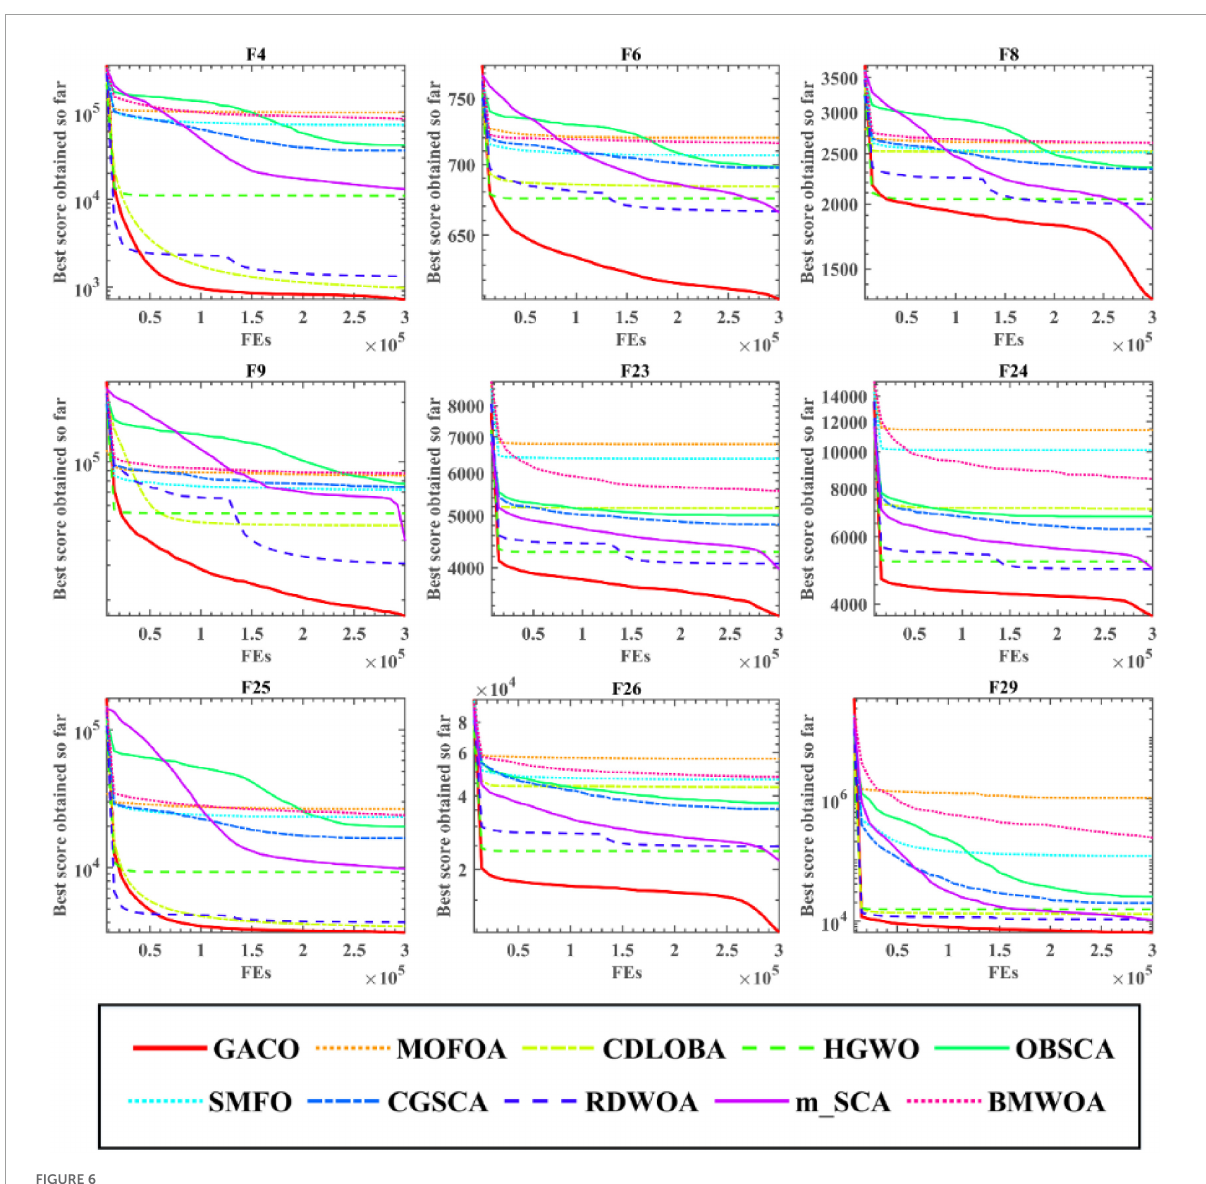
FIGURE6 The convergence curves of all algorithms on some